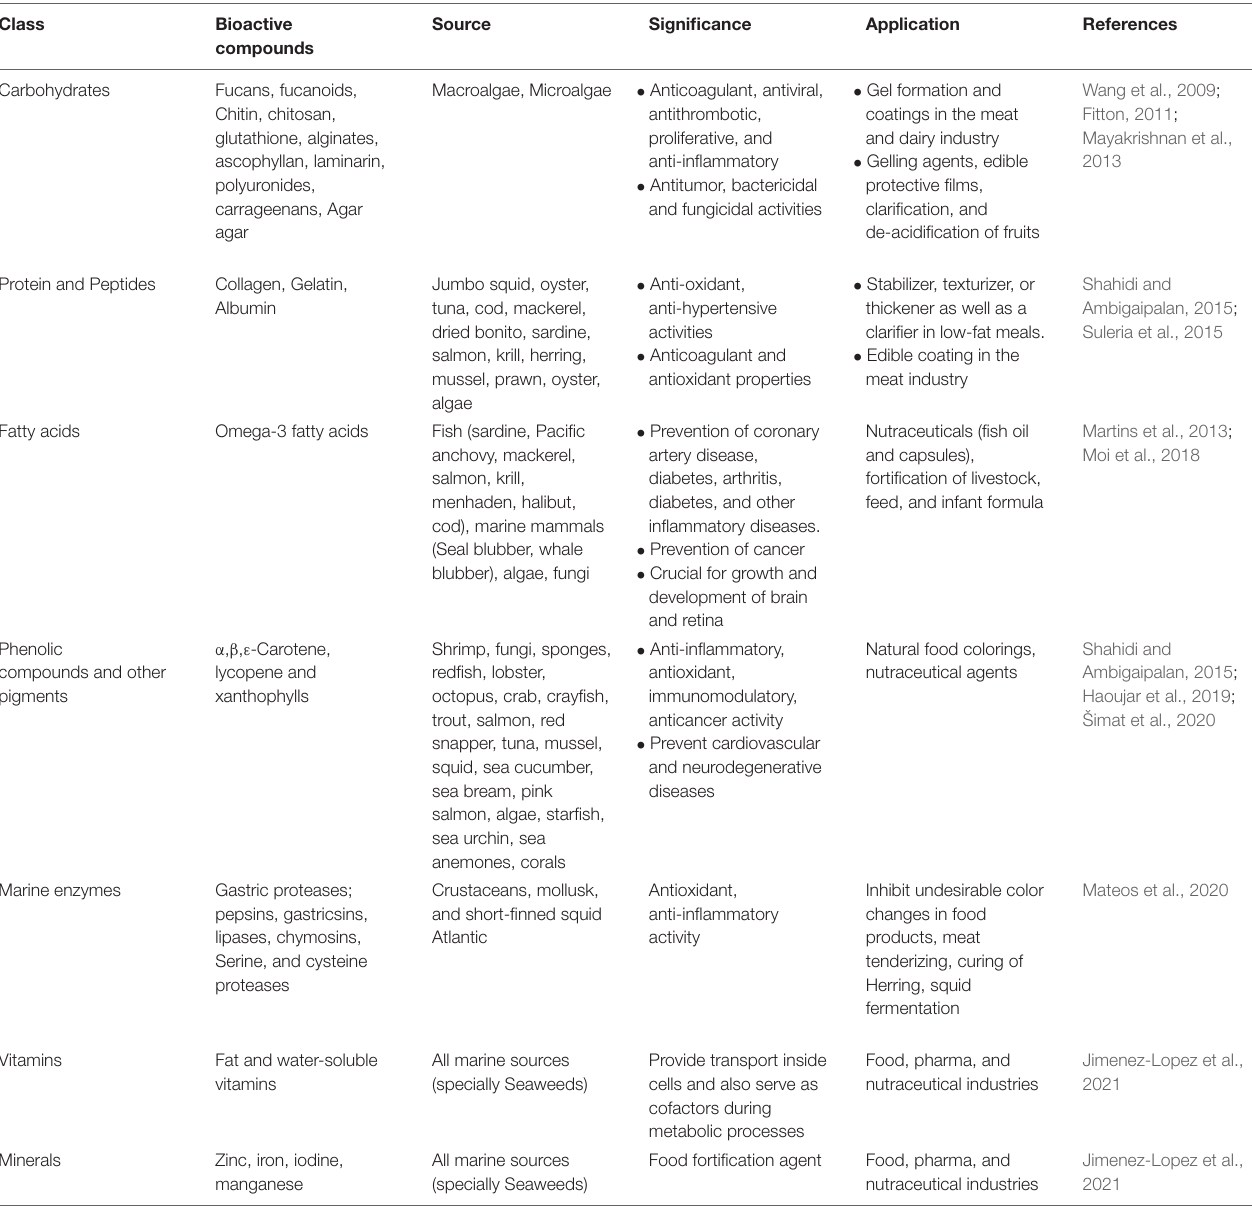
TABLE 1 | Phenolic compounds obtained from different marine